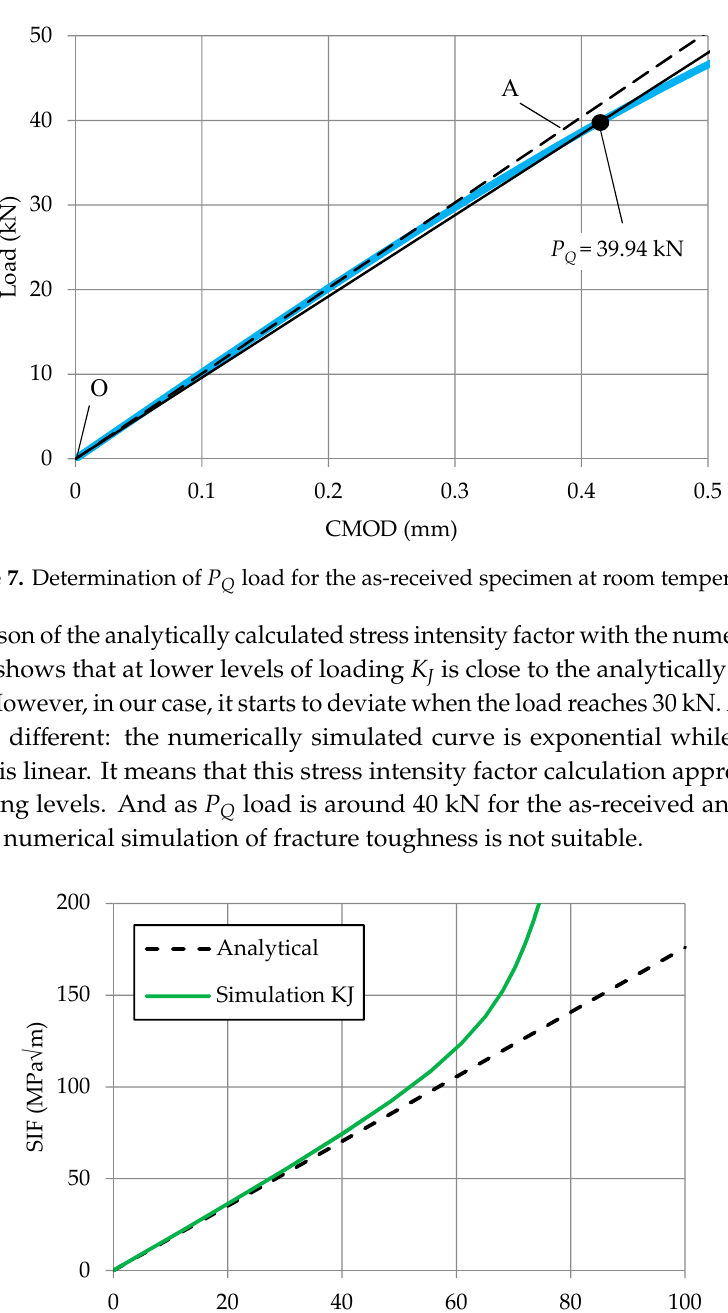
Figure 7. Determination of P Q load for the as-received specimen at room temperature.